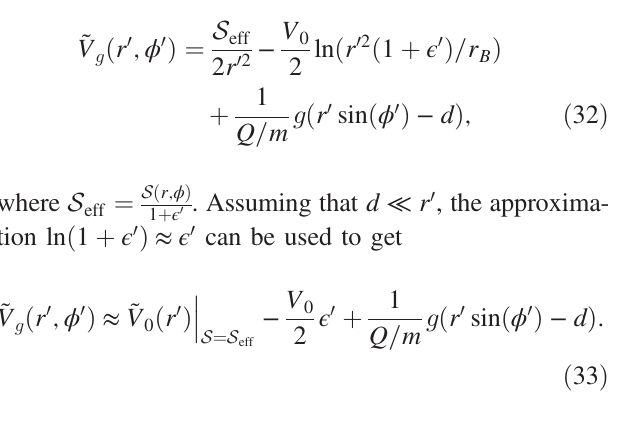
ffiffiffiffiffiffiffiffiffiffiffiffiffiffiffiffiffiffi p − S =V 0 eff